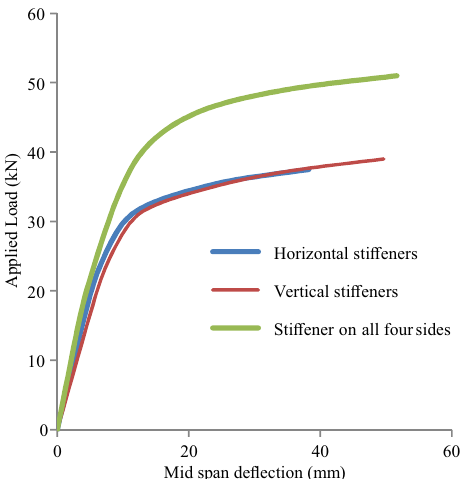
Fig. 15. Load vs mid span deflection for beam of different aspect ratio subjected to uniformly distributed load